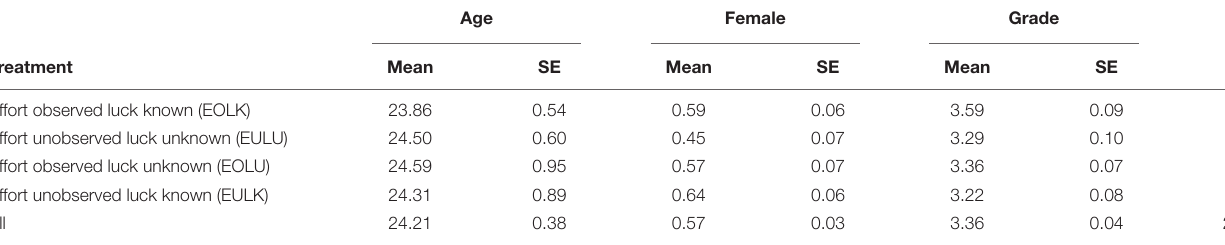
TABLE 2 | Background